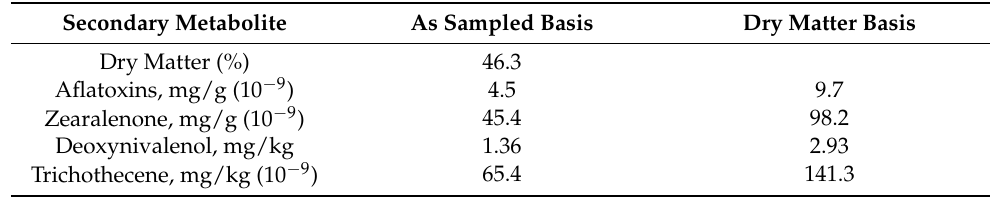
Table 3. Some mycotoxins of powdered T. recurvata